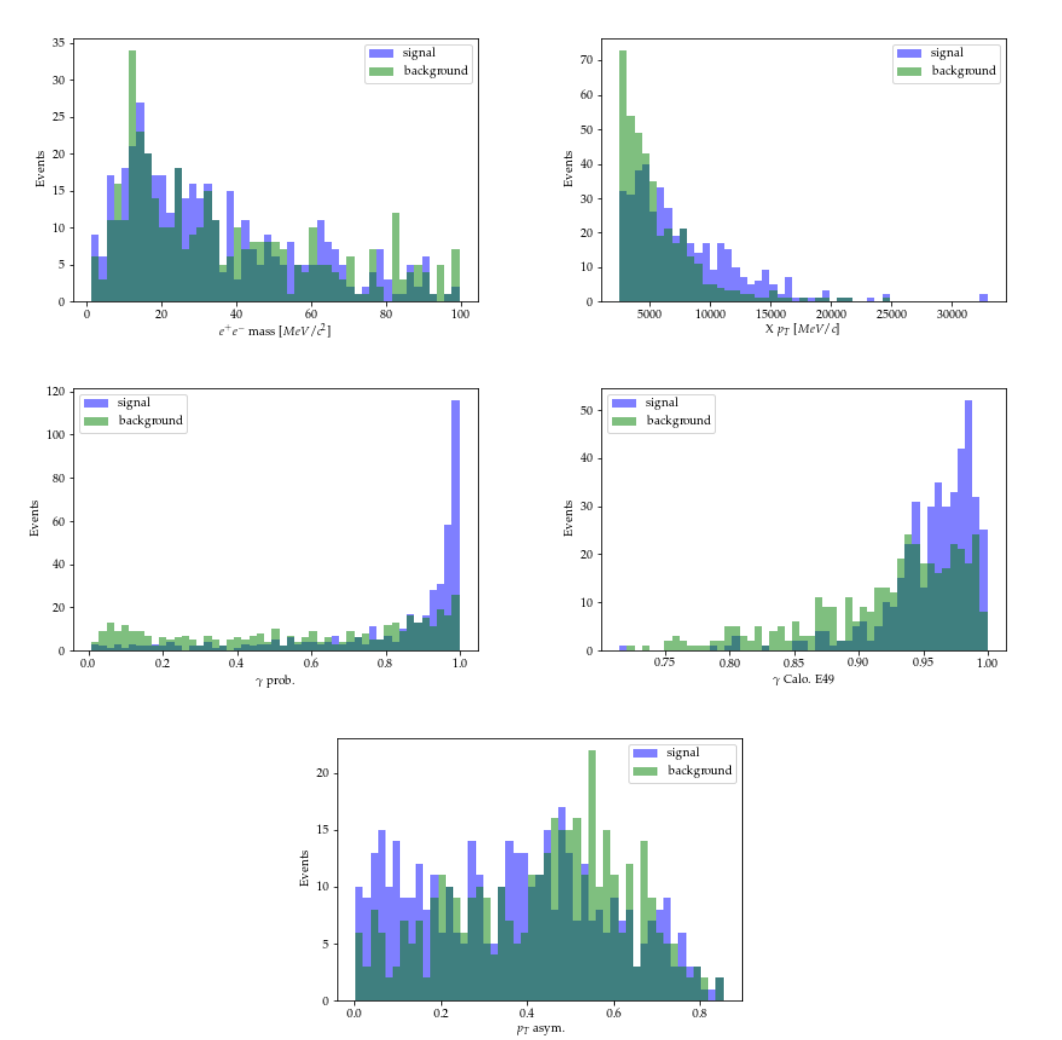
Figure 3: Signal and background distributions of information used to train the 1CV DD classifier. Variables are explained in the